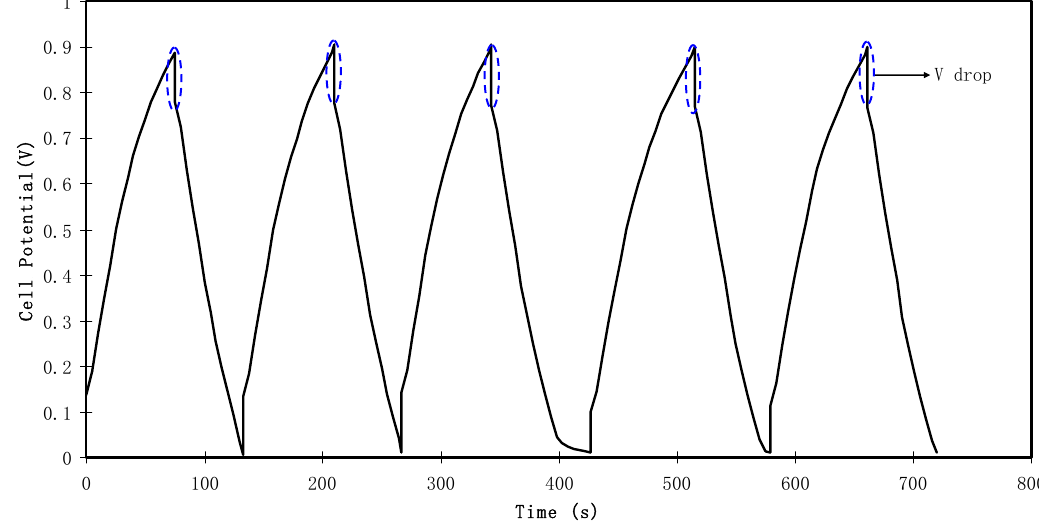
Figure 11. Charge-discharge profiles for the fabricated EDLC at 0.5 mA cm − 2 .